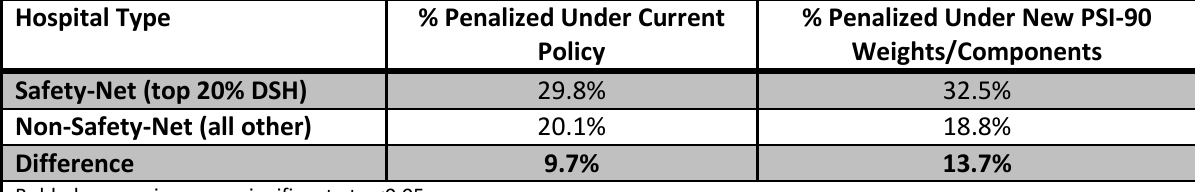
Table 6.23: Percent Penalized Under New PSI-90 Weighting Scheme and 3 Additional